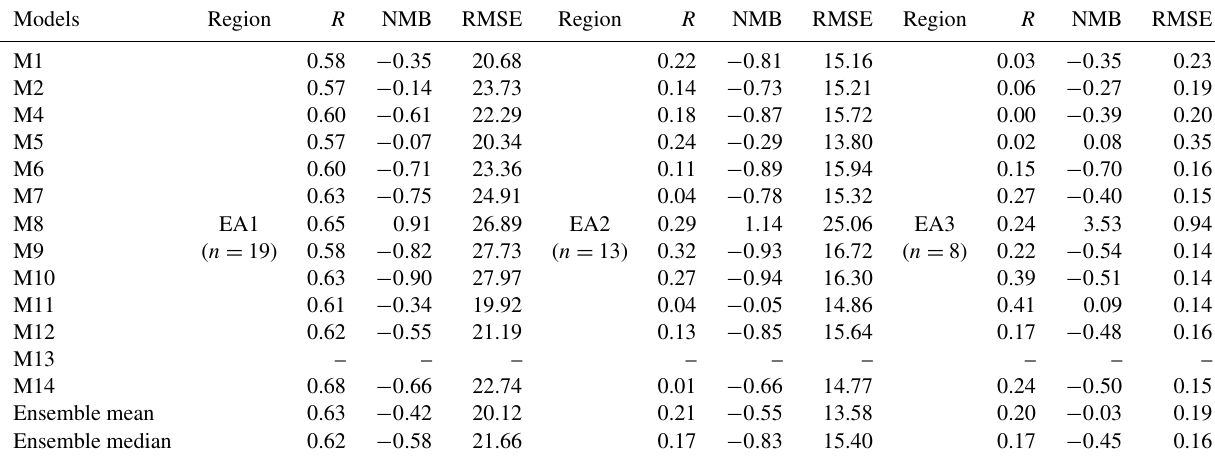
Table 3. Statistical analysis for surface NO in three subregions over East Asia. R denotes the correlation coefficient, NMB is the normalized mean bias and RMSE is the root-mean-square error (units are ppbv). Models